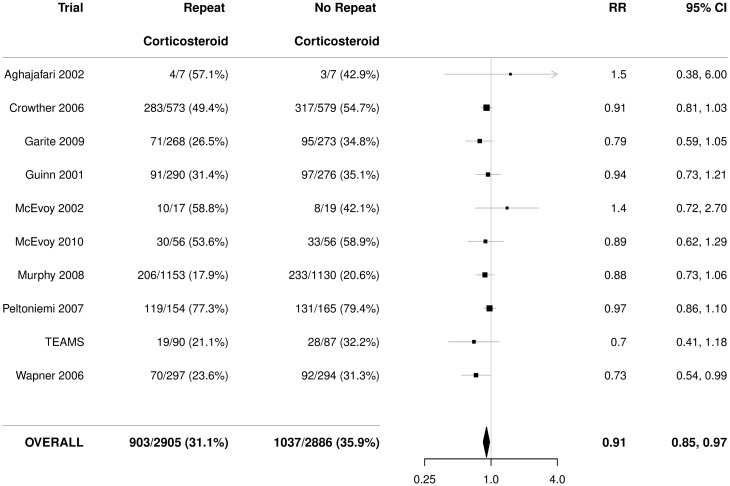
Primary outcome for the infant: Use of respiratory support.Figures are numbers (percentages) with RR and 95% CI as treatment effect. p-value for heterogeneity = 0.64. CI, confidence interval; RR, relative risk; TEAMS, Trial of the Effects of Antenatal Multiple courses of Steroids versus a single course.